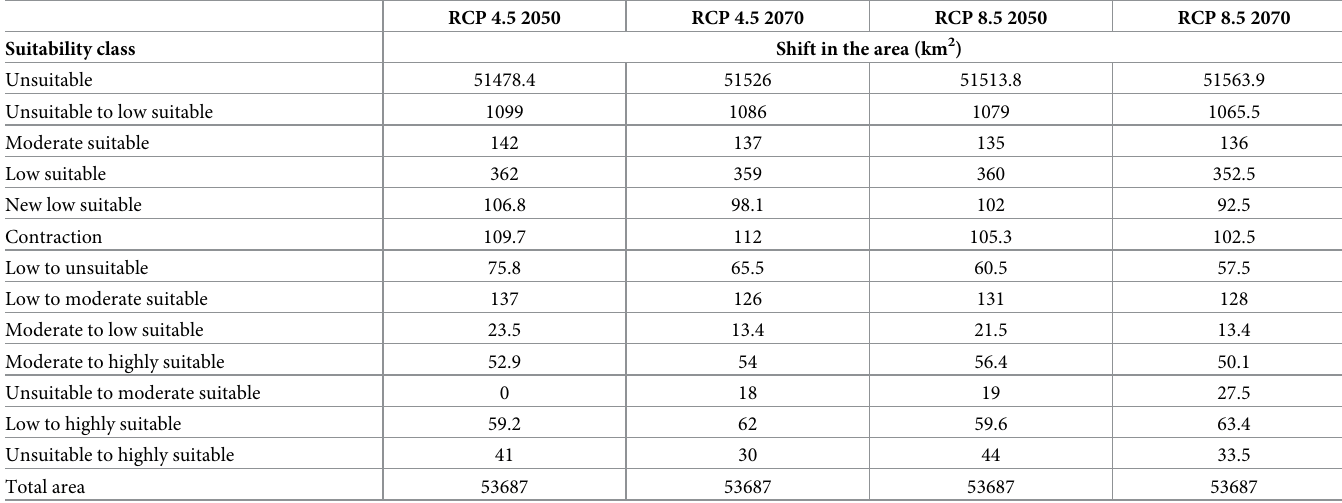
Table 4. Change detection of suitability class by comparison with present distribution as computed in Km 2 under RCP 4.5 and RCP